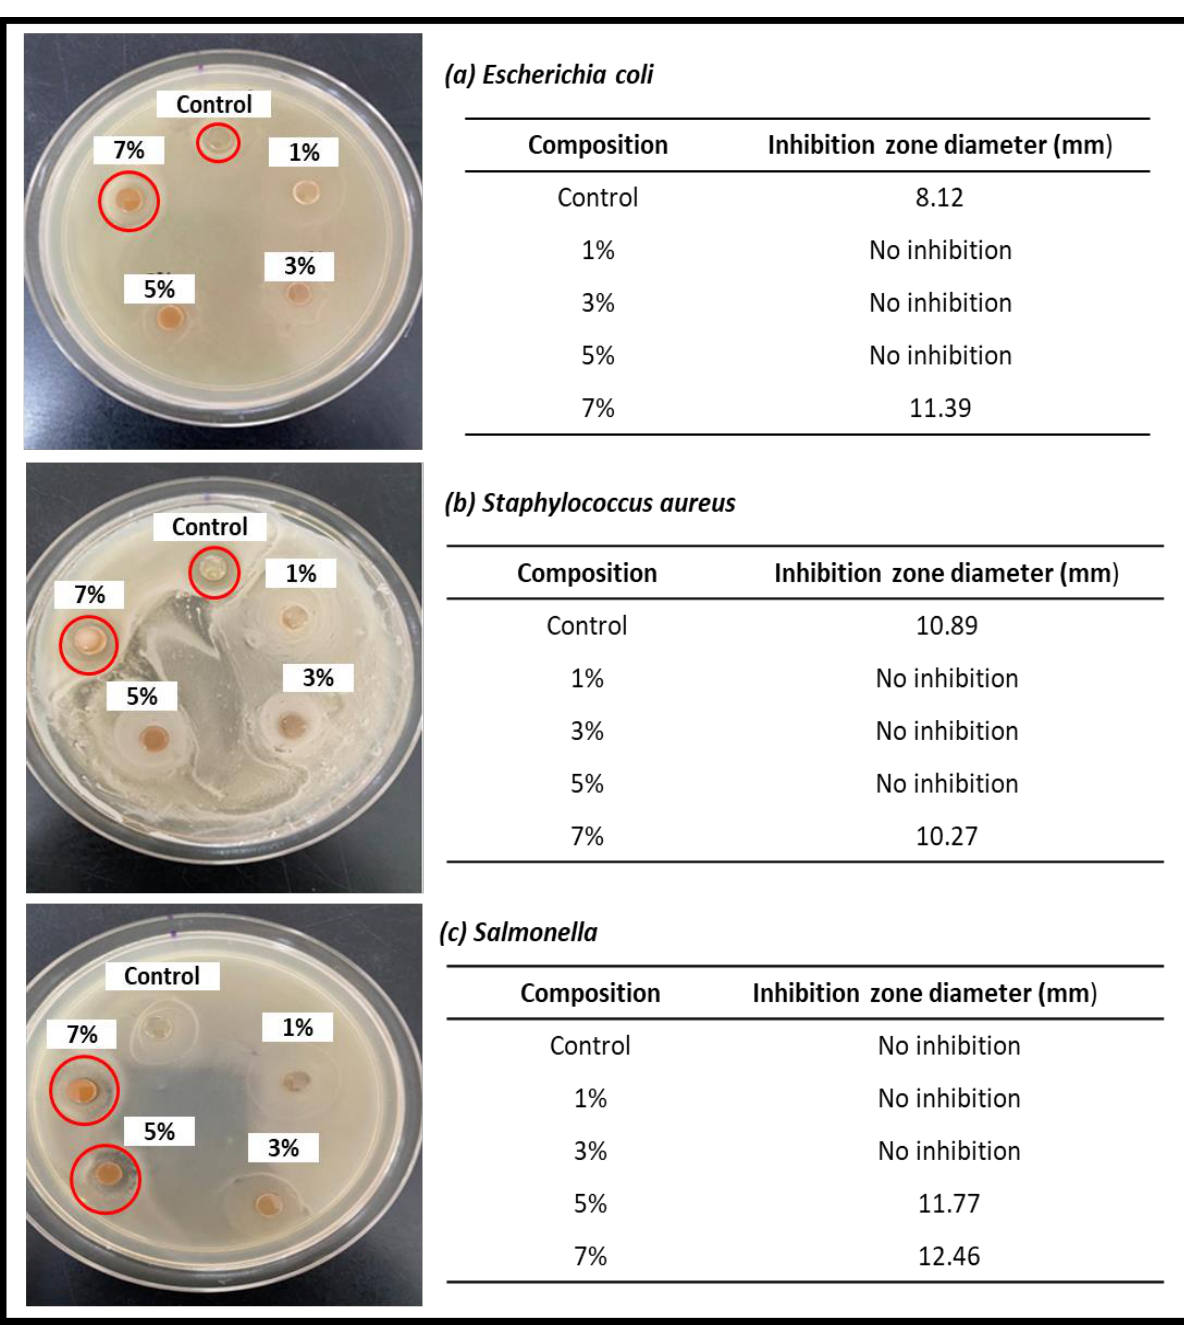
Figure 6. Antimicrobial properties of the seaweed-based cinnamon film against ( a ) E. coli , ( b ) S. aures , and ( c ) Salmonella